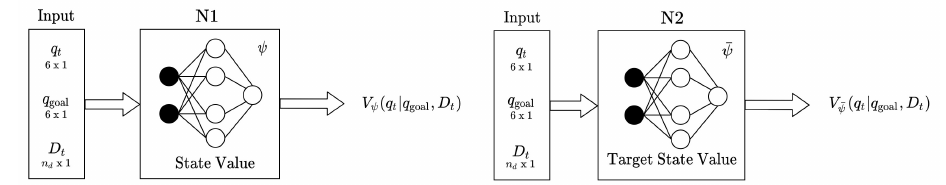
Figure 3. The deep neural network for the state value function